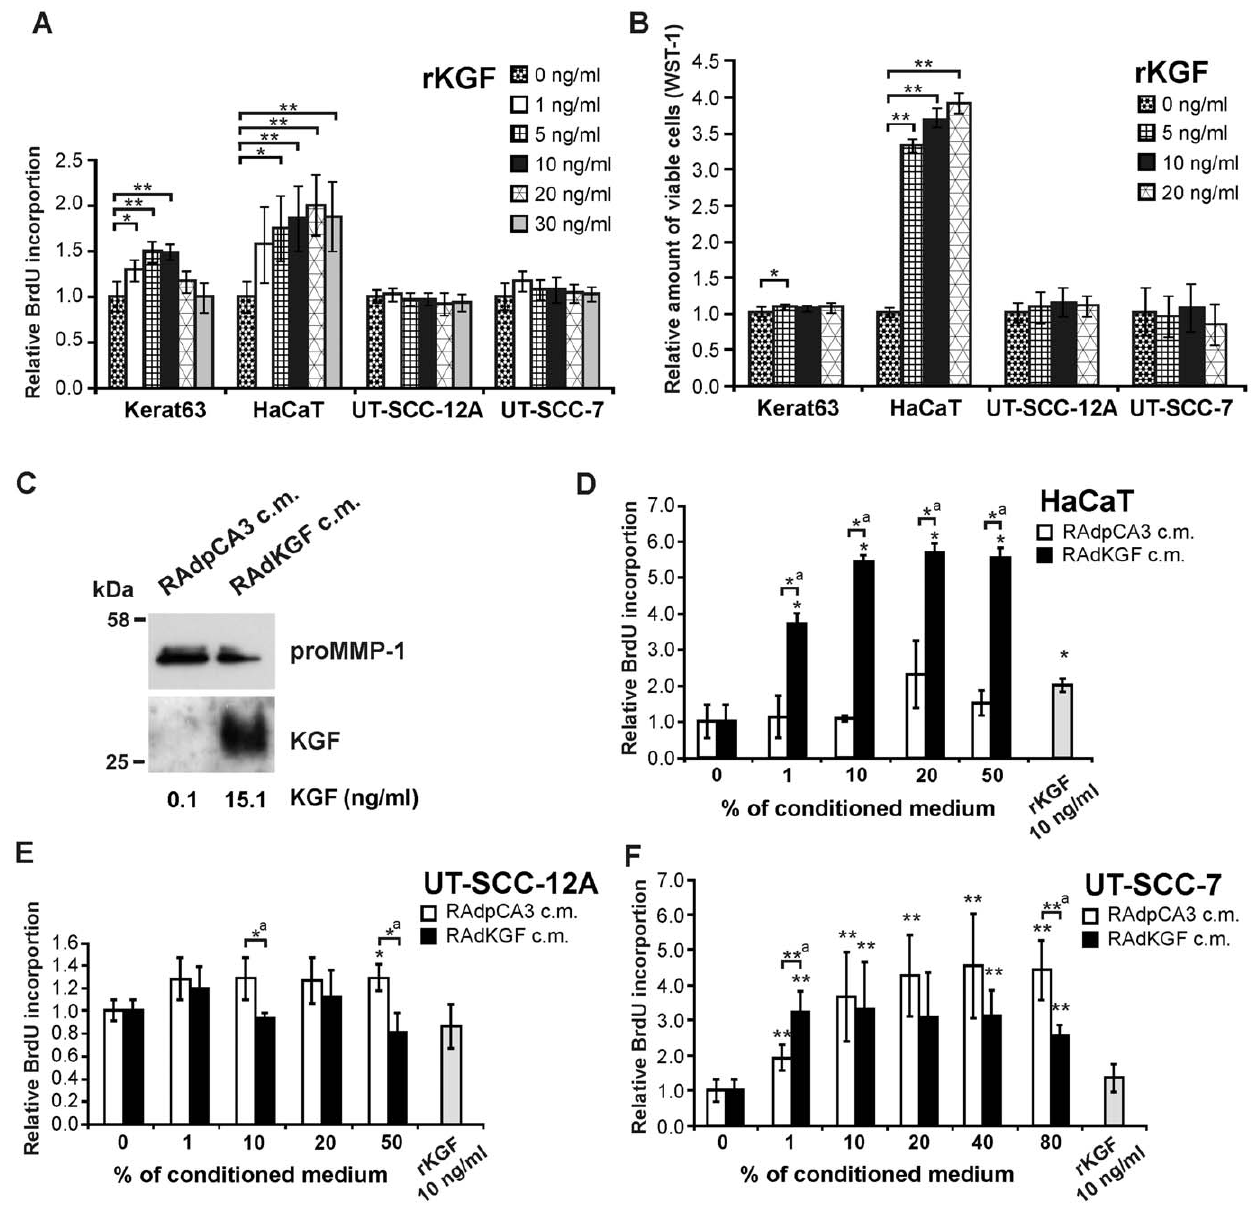
Figure 2. Lack of mitogenic response to KGF in skin SCC cells. ( A ) Growth supplement-starved normal primary keratinocytes (Kerat63), serum-starved HaCaT cells and primary (UT-SCC-12A) and metastatic (UT-SCC-7) cutaneous SCC cells were treated with recombinant KGF (rKGF; 10 ng/ml) for 2 h followed by addition of BrdU. DNA-synthesis was determined as incorporation of BrdU into DNA after 18 h incubation. * p , 0.02; ** p , 0.005, with Mann-Whitney U-test, n=5–6. ( B ) Keratinocytes (Kerat63) (n=8), HaCaT cells (n=12), UT-SCC-12A (n=12) and UT-SCC-7 (n=12) cells were treated as in (A). The relative amount of viable cells was determined using colorimetric assay of WST-1 reagent metabolism. * p , 0.02; ** p , 0.000001, with Mann-Whitney U-test. ( C ) Serum-starved primary human skin fibroblasts were infected with recombinant adenovirus (RAdKGF) coding for human KGF, or with empty control adenovirus (RAdpCA3) (MOI 200) overnight and incubated in DMEM containing 0.5% FCS for 72 h. The conditioned medium (c.m.) was analyzed for the presence of KGF by western blotting, and KGF concentration was quantified with ELISA. ProMMP-1 was visualized as control in c.m. by western blotting. ( D–F ) Serum-starved HaCaT cells ( D ), UT-SCC-12A cells ( E ) and UT-SCC-7 ( F ) cells were incubated with c.m. in indicated concentrations or with rKGF for 18 h. BrdU was added and DNA-synthesis was analyzed after 8 h incubation. * a p , 0.05, ** a p , 0.01, * p , 0.05 compared to 0% c.m., ** p , 0.02 compared to 0% c.m. with Mann-Whitney U-test, n=4–5. doi:10.1371/journal.pone.0033041.g002 treated with rKGF (10 ng/ml) for 24 h. As expected, the compared to normal keratinocytes, and was downregulated by expression of matrilin 2, CXCL10 and IGFBP3 mRNA was KGF in 5 out of 6 KGFR positive SCC cell lines (Figure 4A, upper undetectable or very low in normal keratinocytes (Figure 4A). In panel). CXCL10 mRNA expression was elevated in 3 out of 7 accordance with the microarray data, the basal expression of SCC cell lines compared to keratinocytes and KGF treatment matrilin 2 mRNA was markedly elevated in all SCC cell lines, as downregulated the expression significantly in 2 SCC cell lines